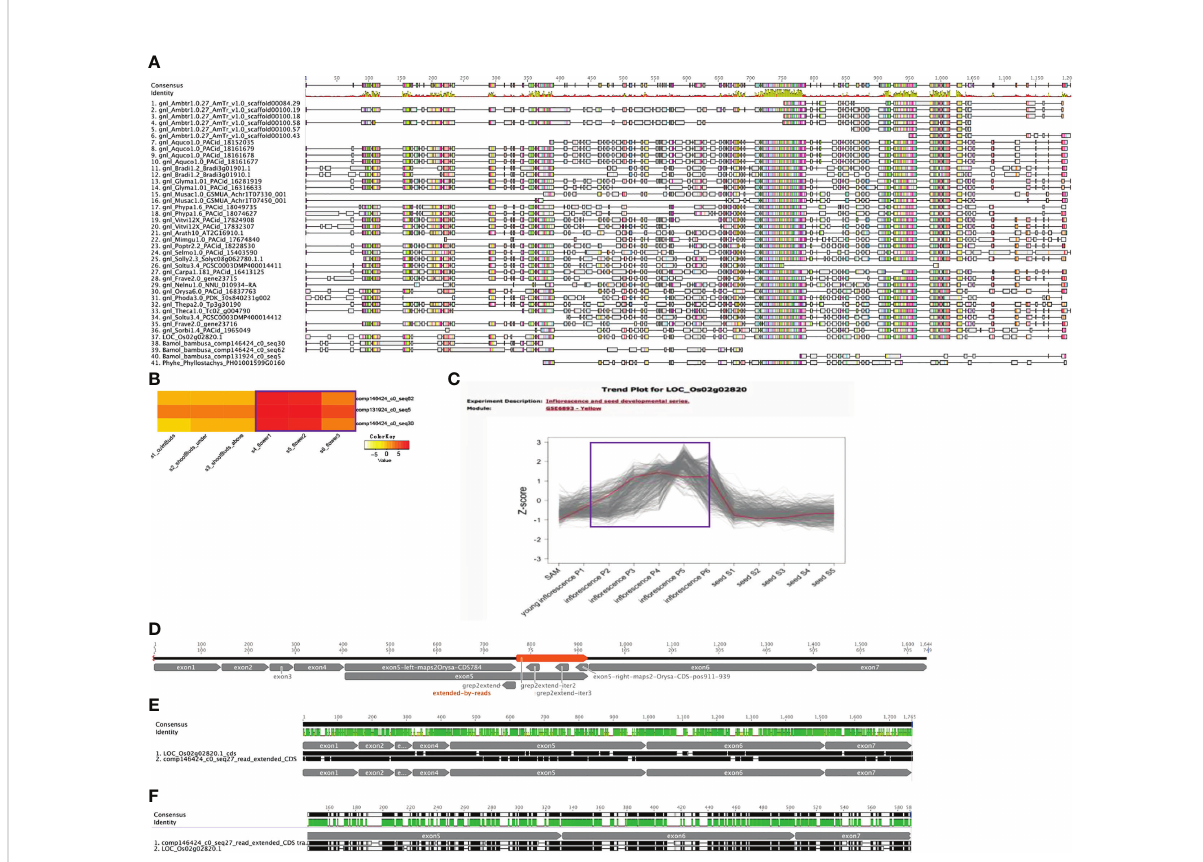
FIGURE 6 Conserved AMS protein sequence evolution in B. oldhamii ‘ Xia Zao ’ . (A) Orthogroup protein multiple sequence alignment (MSA) shows fragmented AMS contigs in B, oldhamii ‘ Xia Zao ’ . (B) and (C) show different expression trend of AMS gene expression in fl ower stages, (B) shows expression of AMS contigs in B. oldhamii ‘ Xia Zao ’ , (C) shows expression of rice AMS . The purple line in B and C indicates the trend of AMS gene expression in B. oldhamii ‘ Xia Zao ’ and rice, respectively. (D) A schema illustrates the process of full-length CDS construction. Exon 1, exon 2, exon 3, exon 4, exon 6, exon 7 were constructed by high sequence similarity in assembled contigs with rice CDS. The left region of exon 5 up to 784 bp of rice AMS CDS and the right region of exon 5 from 911 to 939 were constructed by comparing B. oldhamii ‘ Xia Zao ’ transcriptome assemblies to rice CDS. The gap in the middle of exon 5 (orange region labeled as “ extended-by-reads ” ) were fi lled by using read sequence data. In this process, three seeds were used to perform “ grep ” command in the reads to extend the right regions, and three iterations ( “ grep2extend ” , “ grep2extend-iter2 ” , and “ grep2extend-iter3 ” ) were able to fi ll the gap in exon 5. (E, F) are the pairwise alignment (from Geneious) of full-length AMS CDS and peptide sequence between B. oldhamii ‘ Xia Zao ’ and